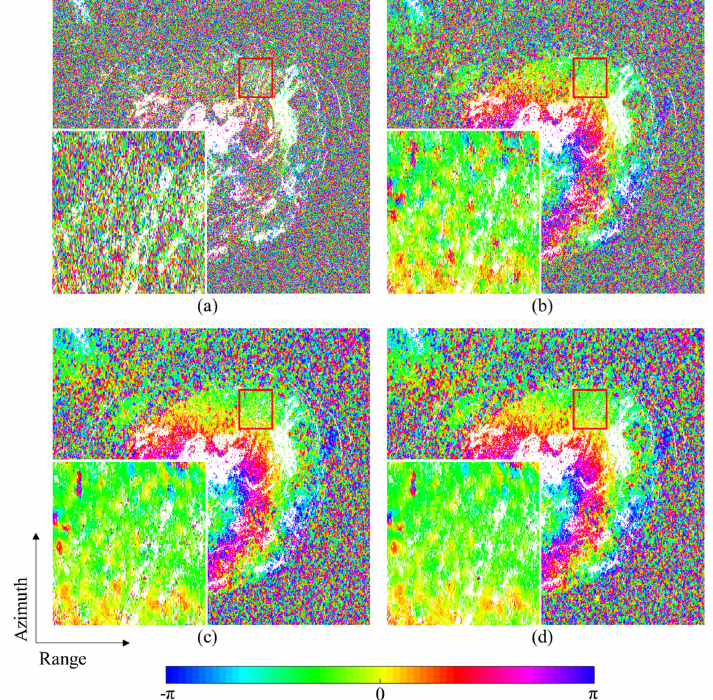
Figure 11. The original and reconstructed interferometric phases with the longest temporal baseline of 288 days. An area denoted by the red rectangle is enlarged. ( a ) Original single look interferogram. Reconstructed phases using: ( b ) the sample coherence magnitude ˆ γ , ( c ) the corrected coherence magnitude γ , ( d ) the corrected coherence magnitude (cid:101) γ proposed in this paper. The reconstructed interferograms can be further visualized by profile